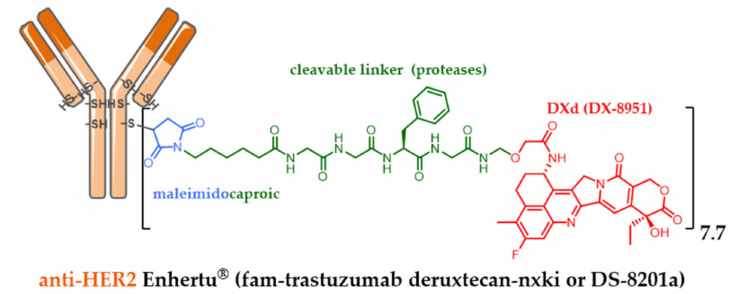
Figure 16. Enhertu ® (fam-trastuzumab deruxtecan-nxki or DS-8201a) formula, ADC with a DAR 7.7, resulting from anti-HER2 trastuzumab conjugation to exatecan DX-8951 via a linker sensitive to